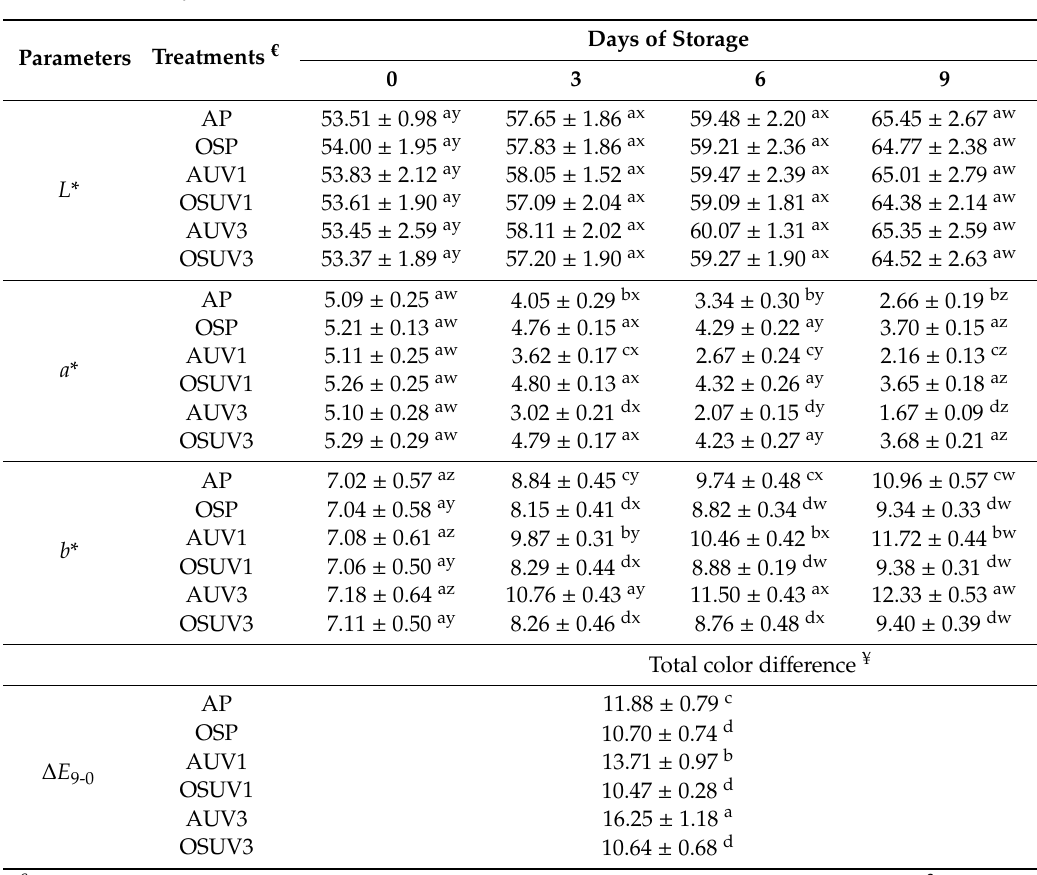
Table 3. L * (lightness), a * (redness) and b * (yellowness) of rainbow trout ( Oncorhynchus mykiss ) fillets non- and treated with oxygen scavenger packaging (OSP) and ultraviolet radiation (UV-C) stored at 4 ± 1 ◦ C for 9